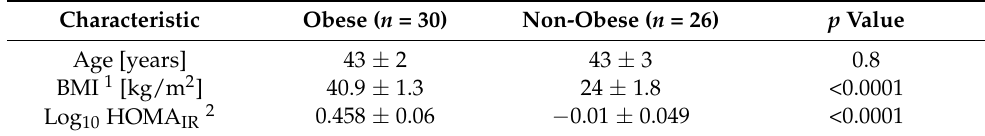
Figure 1. SLC2A4 and DNL-associated gene expression in publicly available transcriptomic data. ( a ) Schematic hypothesis. Fatty acid uptake into the adipocyte may alter DNA methylation of the SLC2A4 gene, which leads to decreased GLUT4 protein levels and reduced insulin-stimulated glucose uptake. Consequently, ChREBP activity and de novo lipogenesis decrease. ( b ) Human cohorts of publicly available transcriptomic data used for analysis. ( c ) Volcano plot of publicly available transcriptome data (GSE25401) from subcutaneous adipose tissue of non-obese and obese normoglycemic individuals. Highlighted are genes involved in de novo lipogenesis (ACACA, FASN, PKM), glucose metabolism (SLC2A4, MLXIPL), and fatty acid transport (CD36). Colored dots represent genes that fulfill the criteria: p -value < 0.05, log2 Fold change > − 0.5 or 0.5; ( d ) Volcano plot of publicly available transcriptome data (GSE20950) from visceral adipose tissue of obese, insulin sensitive (IS) and obese, insulin resistant (IR) subjects. Highlighted are the same genes as in ( c ). Colored dots represent genes that fulfill the criteria: p -value < 0.05, log2 Fold change > − 0.5 or 0.5 epiWAT–epididymal white adipose tissue, SAT–subcutaneous adipose tissue, IS–insulin sensitive, IR–insulin resistant. Table 1. Metabolic parameters of the GSE25401 cohort (modified